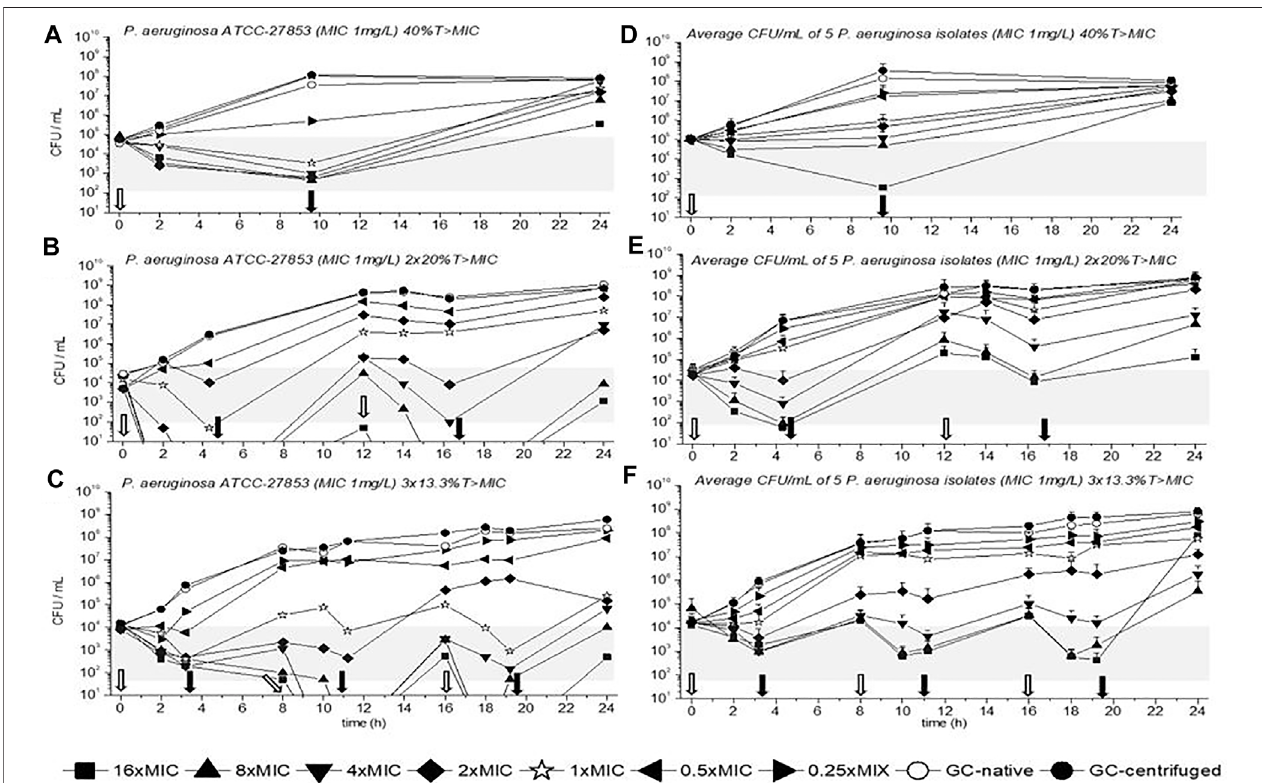
FIGURE2| Timekillcurves(TKC)withmeropenemof P.aeruginosa ATCC-27853 (A) , (B) , (C) andoftheaverageCFU/mLof fi ve P.aeruginosa isolates (D) , (E) , (F) are shown over 24 h with standard deviation. In (A) , (B), and (C) the standard deviations are very small and overlaid by symbols. The circular symbols represent the growthcontrols; fi lledshowthecentrifugedandemptydepictthenativegrowthcontrol(GC).Theconcentrationoftheminimalinhibitoryconcentration(MIC)ofthetested strains is given as a star symbol. Empty arrows indicate antibiotic addition and fi lled arrows indicate antibiotic removal.